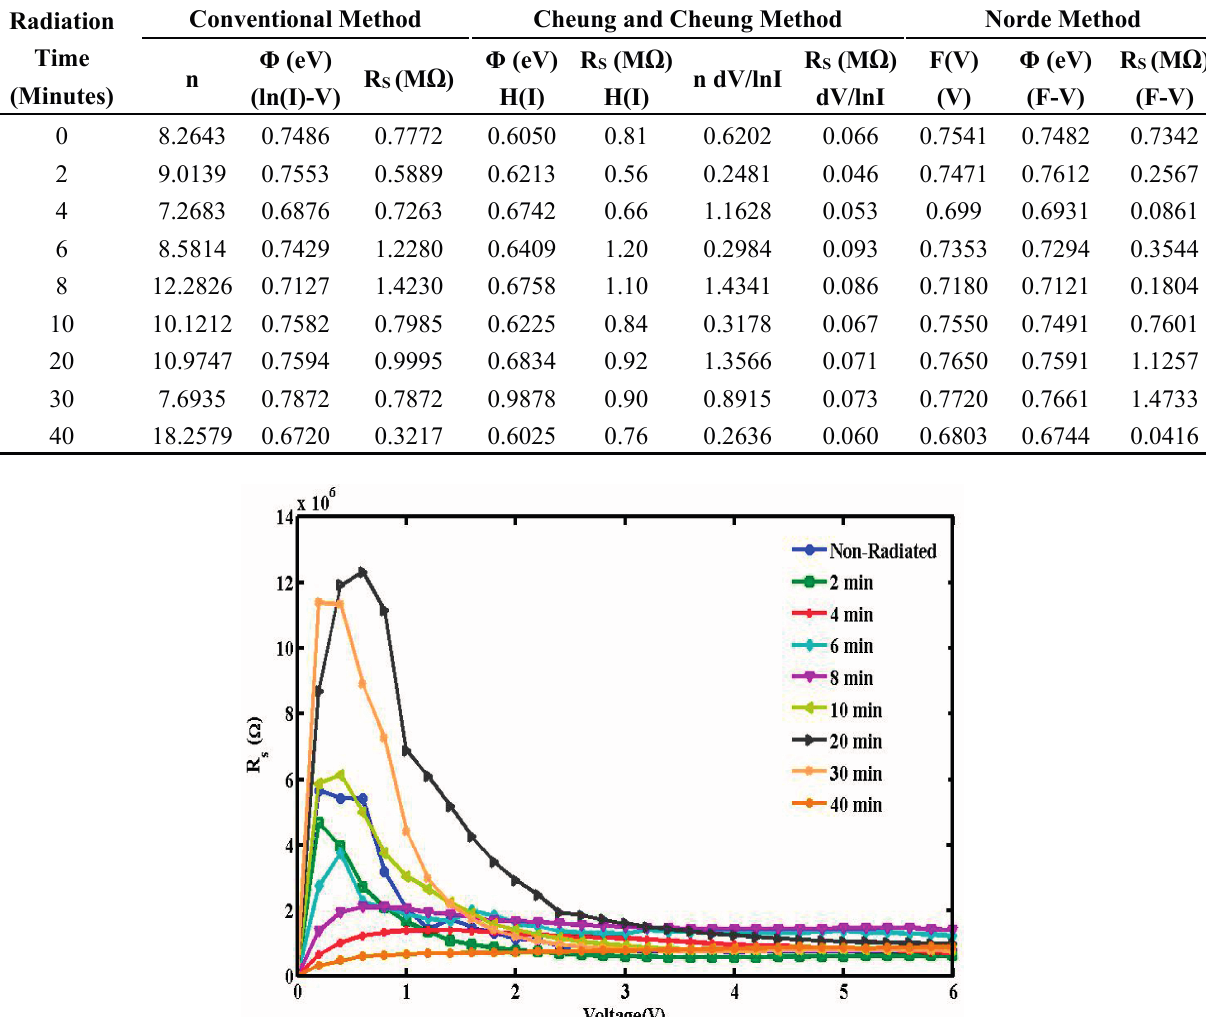
Table 1. Values of ideality factor, barrier height and series resistance measured.